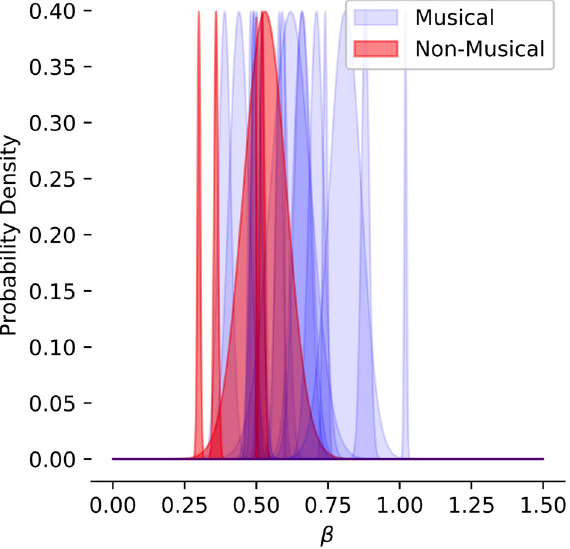
Figure 8. The distribution of spectral indices for each species are shown with blue representing musical species and red representing non-musical ones, according to the criteria laid out in Section III. These distributions are normal with variance and mean set to reflect the population variance and mean as given in SI Table